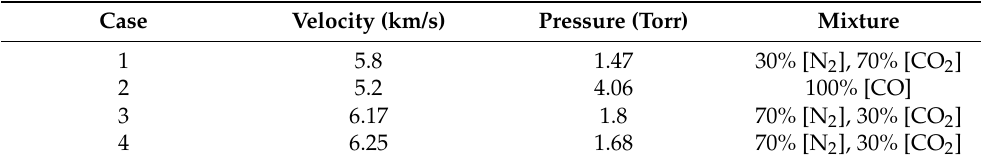
Table 5. Tests carried out in TCM2 for Mars entry.